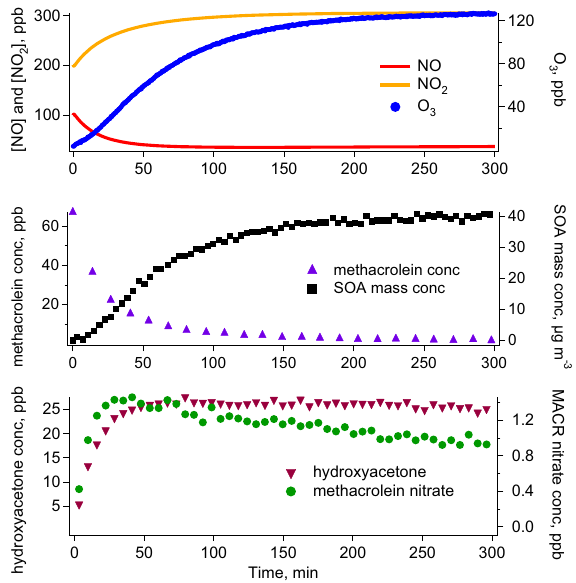
Fig. 2. Concentration profiles of gas-phase species during a typ- ical methacrolein/high-NO 2 experiment (15/09/09). Additional NO (100ppb) and NO 2 (200ppb) were injected prior to irradia- tion. Concentrations of NO and NO 2 shown here are calculated from a photochemical model (see Appendix). As a result of the higher OH concentrations from CH 3 ONO than from HONO, more methacrolein was reacted and the concentrations of methacrolein nitrate relative to those of hydroxyacetone were lower than those in high-NO experiments, owing to a more rapid consumption by